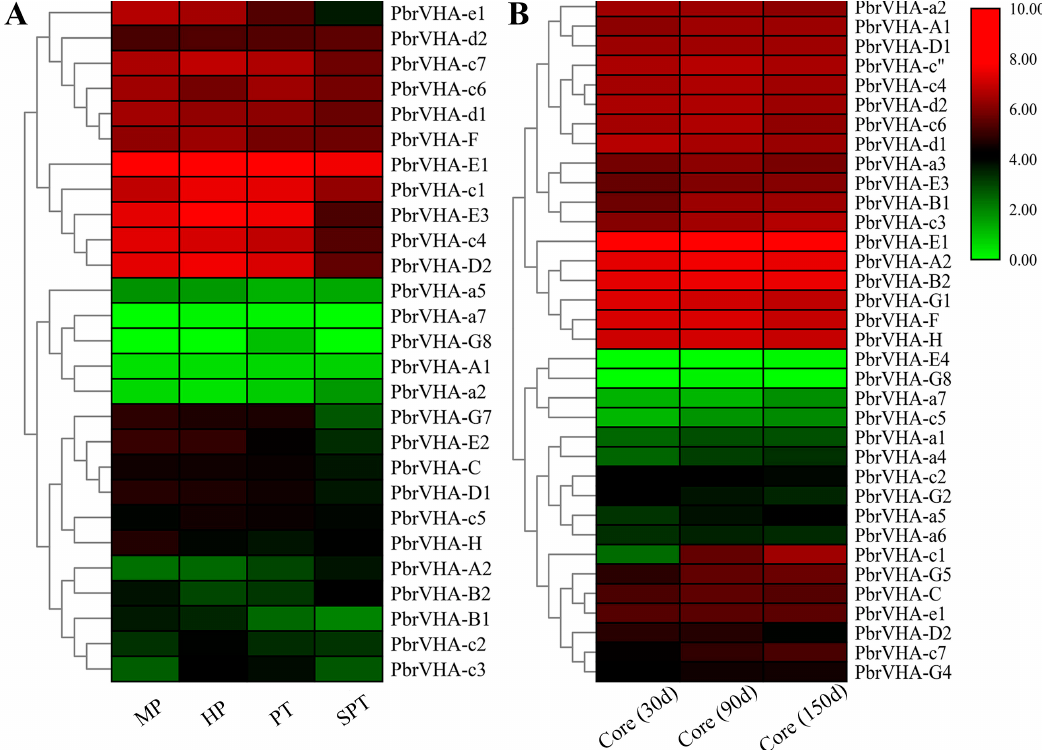
Figure 6. Expression profiles of PbrVHA genes during pollen tube development and fruit senescence. ( A ) The expression of PbrVHA genes during four development stages of pear pollen, including mature pollen grains (MP), hydrated pollen grains (HP), growing pollen tubes (PT) and stopped-growth pollen tubes (SPT). ( B ) Expression profiles of PbrVHA genes in the pear core during fruit storage at three stage (30d, 90d and 150d after harvesting). Color scale represents log2-transformed FPKM + 1 values. Green, black, and red indicate low, moderate, and high levels, respectively.